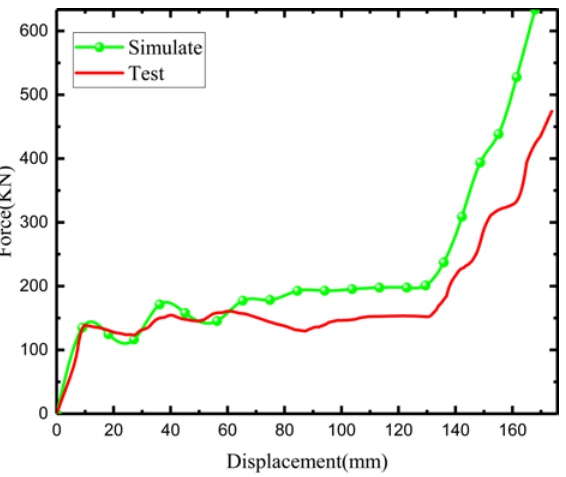
Figure 21. Comparison of load–displacement curves in simulation and experiment (type B).